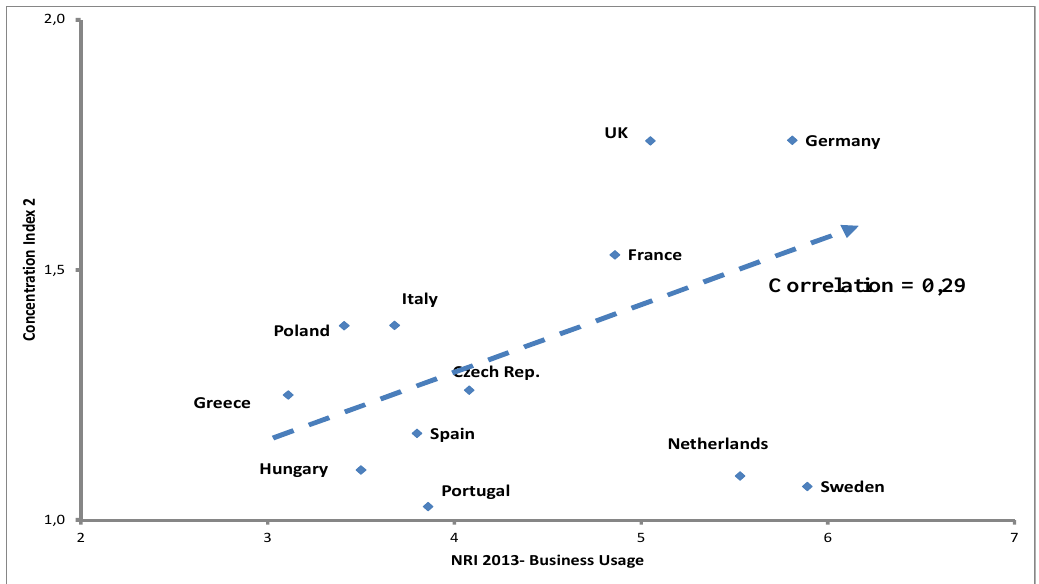
Graph 6 : Correlation between Concentration (Percentage of the National Workforce Employed in the Five Provinces with the Highest Number of Workers) and Use of Internet from Business,